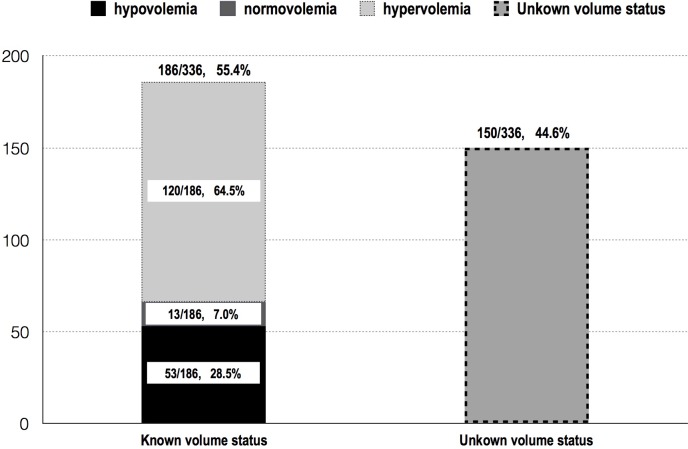
Volume status estimated by IVC examination on admission.